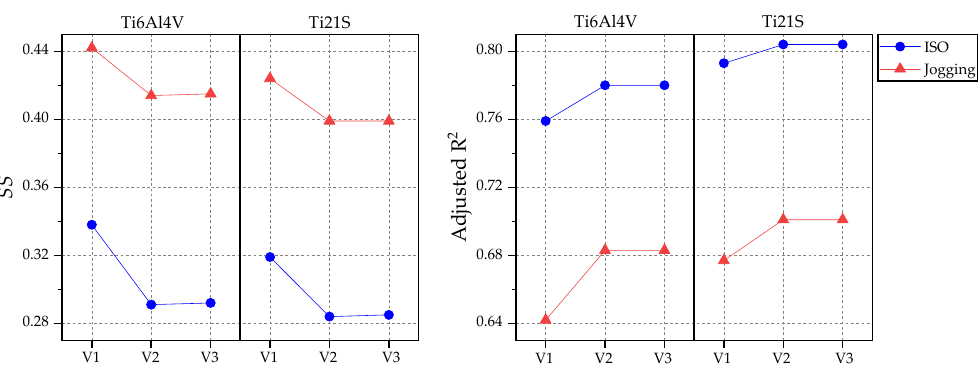
Figure 13. Graphs of the 𝑆𝑆 and adjusted R 2 for GC1.